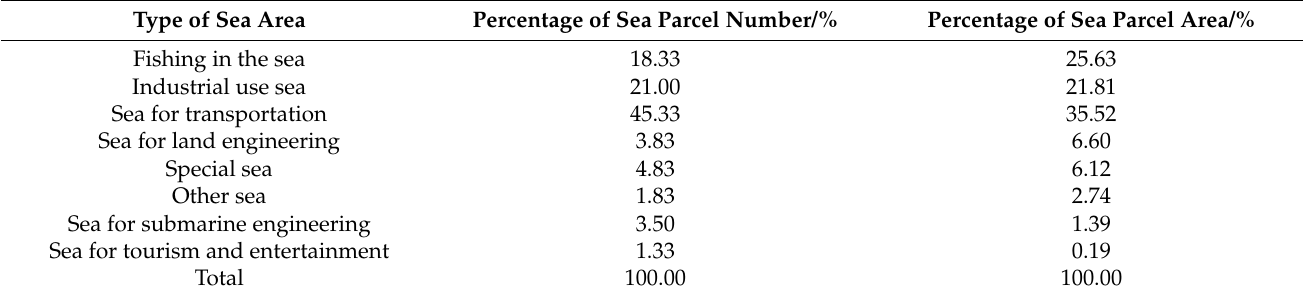
Table 4. The utilization structure of sea area in Wenzhou from 2013 to